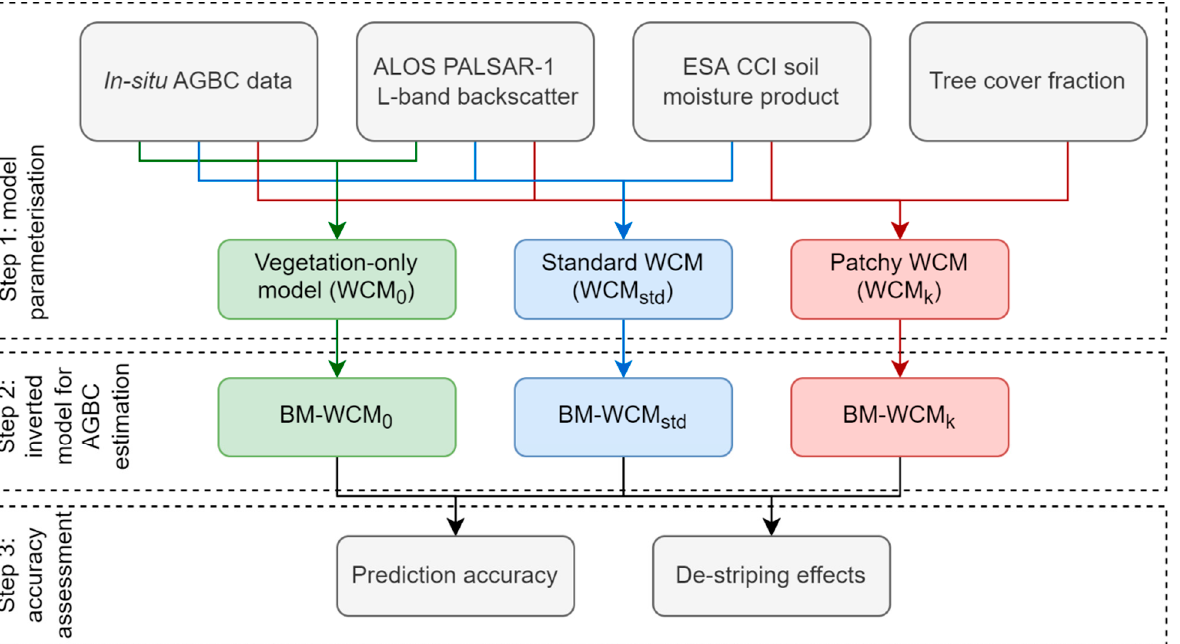
Figure 4. Workflow of this study, consisting of model parameterisation, inverted model for AGBC estimation, and accuracy assessment to compare the efficiency of WCM in correcting soil moisture in AGBC retrieval.